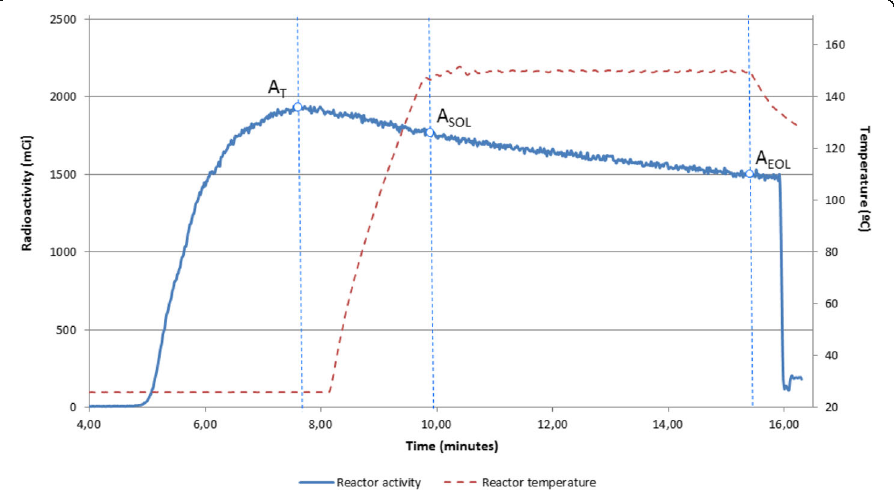
Fig. 1 The evolution of the radioactivity and labelling temperature within the reaction vessel. A T : maximum [ 11 C]CO 2 radioactivity trapped in the reactor; A SOL : Radioactivity at the Start of Labelling; A EOL : Radioactivity at the End of